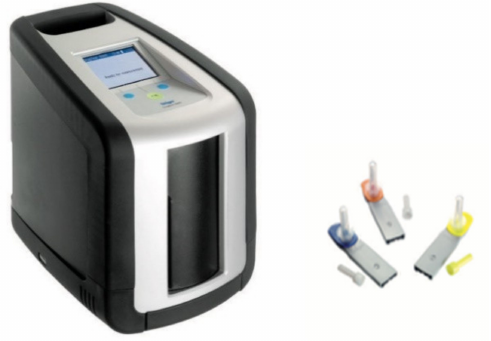
Figure 4. Dräger DrugTest ® 5000 device (reproduced with permission from Elsevier, Ref.